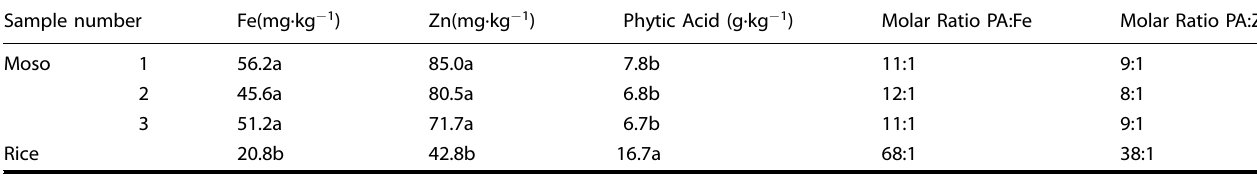
Table 1. Fe Zn and phytic acid (PA) concentration of Moso bamboo seeds and rice. Sample number